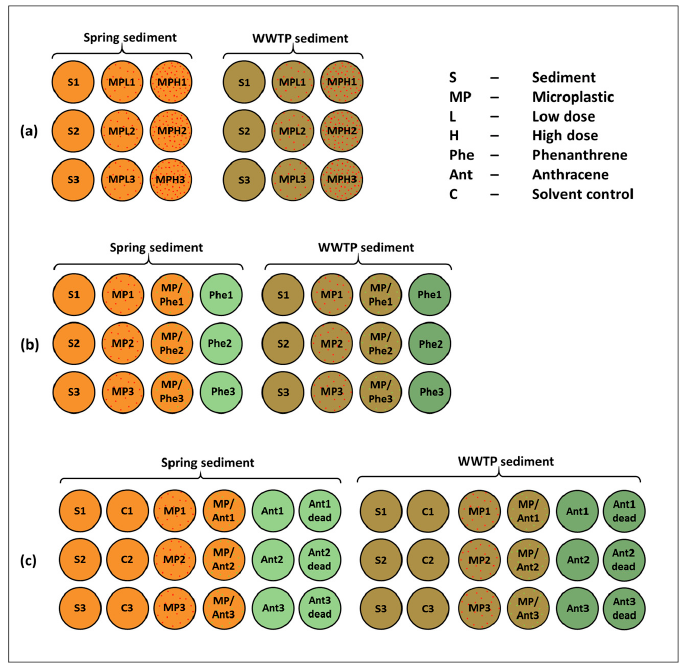
Figure 2. Experimental setup of the three individual experiments with ( a ) microplastic alone, ( b ) phenanthrene and microplastic and ( c ) anthracene and